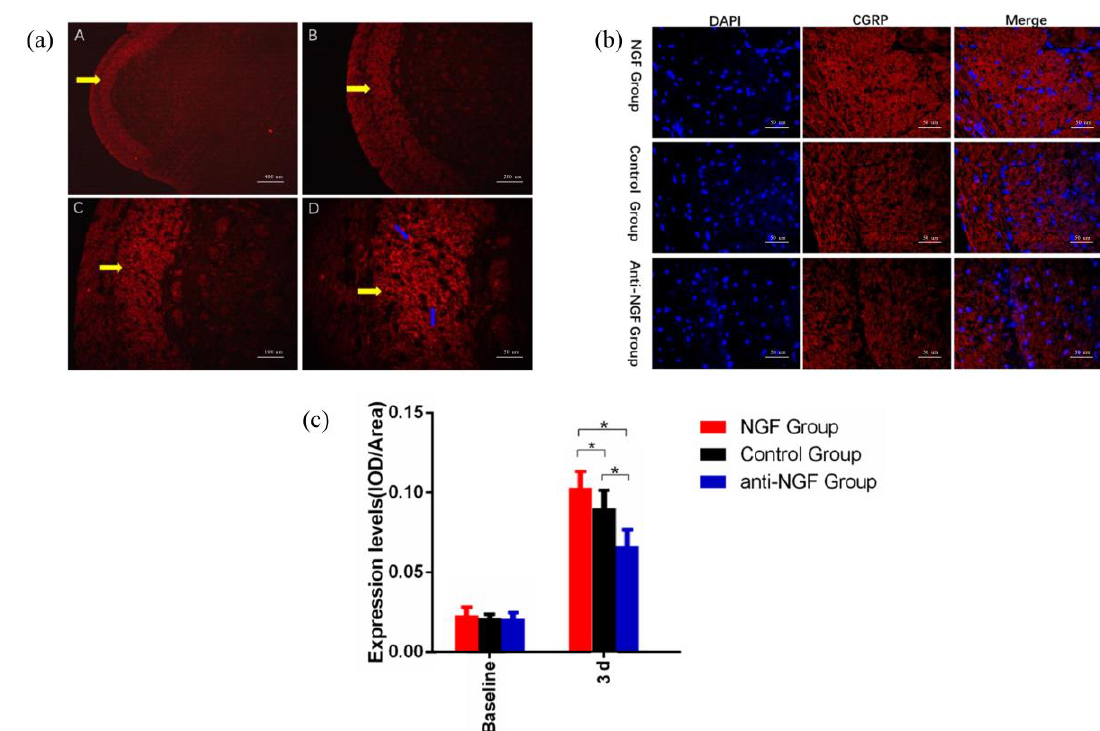
Figure 2. The expression of CGRP in Trigeminal Subnucleus Caudalis (Vc) in the orofacial pain model in different groups. ( a ) The yellow arrow indicates the position of the superficial layer of Vc, and the blue arrow indicates the CGRP-positive nerve fibers (A: ×50; B: ×100; C: × 200; D: × 400). ( b ) Immunofluorescence detection of CGRP expression in the superficial layer of Vc in NGF group, Control group, and Anti-NGF group at 3d (×400). ( c ) The comparison of CGRP expression levels between NGF group, the Control group, and Anti-NGF group (Data are presented as mean ± SD, n = 6. *: p < 0.05).